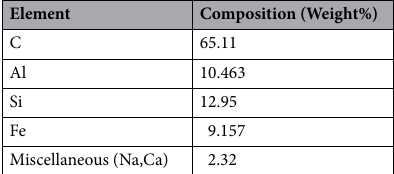
Table 4. Elemental composition of the spatter.